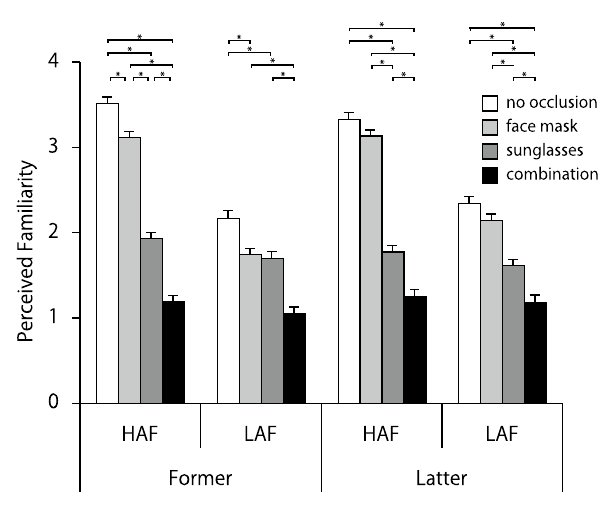
Fig. 5 Mean familiarity ratings for each condition. Error bars represent standard errors. Lines with * indicate that Bonferroni-corrected pairwise comparisons between condi- tions were significant, p <